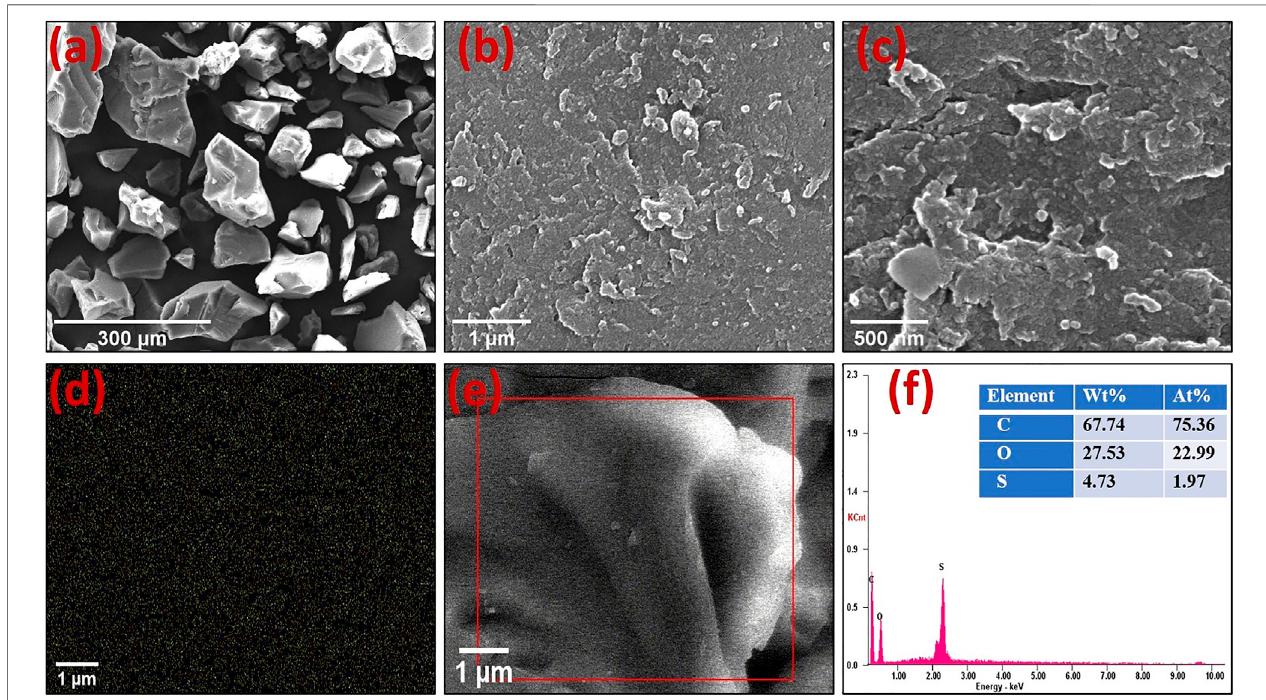
Frontiers in Catalysis |